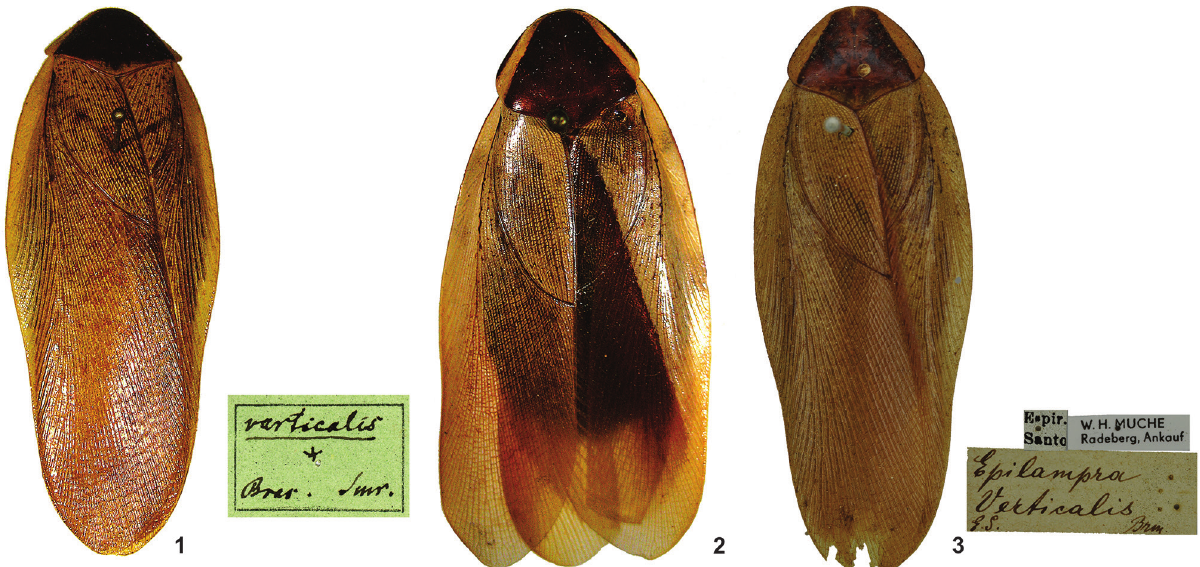
Figures 1–3. Poeciloderrhis verticalis : (1) habitus, dorsal view, female deposited in Halle Museum, length 40.5 mm; (2) habitus, dorsal view, female from deposited in Halle Museum, lenght 40.5 mm; (3) habitus, dorsal view, male deposited in Senkenbergisches Institut, lenght 40.5